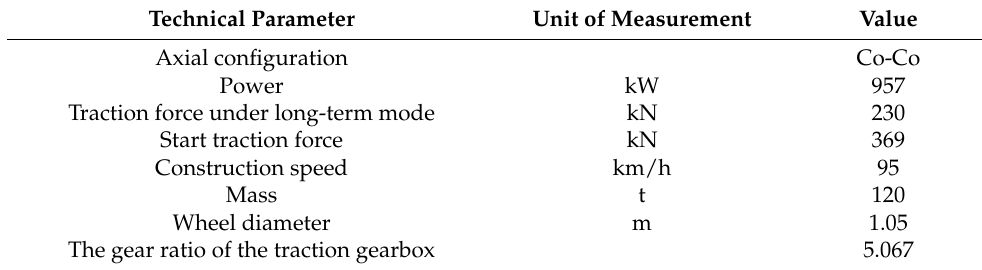
Table 1. Technical parameters of ChME3 locomotive.